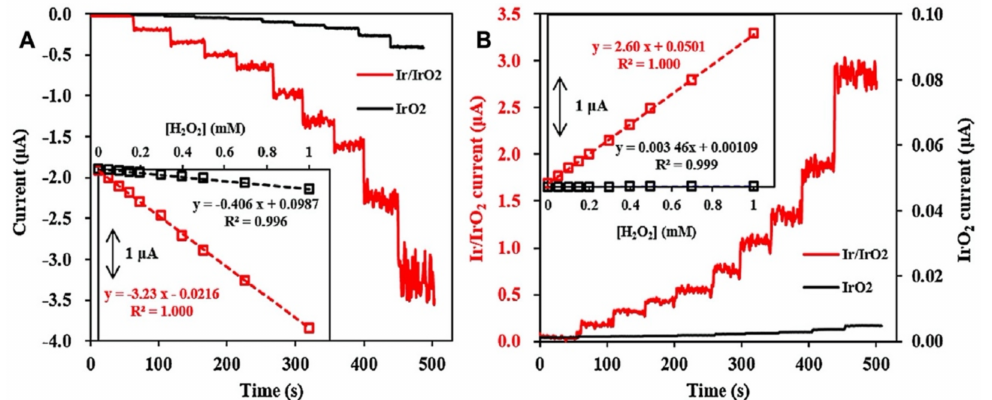
Figure 6. Anodic amperometric responses of IrO 2 NW-Au (black) and Ir/IrO 2 NW-Au (red) to H 2 O 2 concentration (from 0 to 1.0 mM) at 0.43 V ( A ) and cathodic amperometric at − 0.03 V behavior of two sets ( B ). Insets show the corresponding calibration curves. Reprinted with permission of reference [28]. Copyright 2015 Elsevier